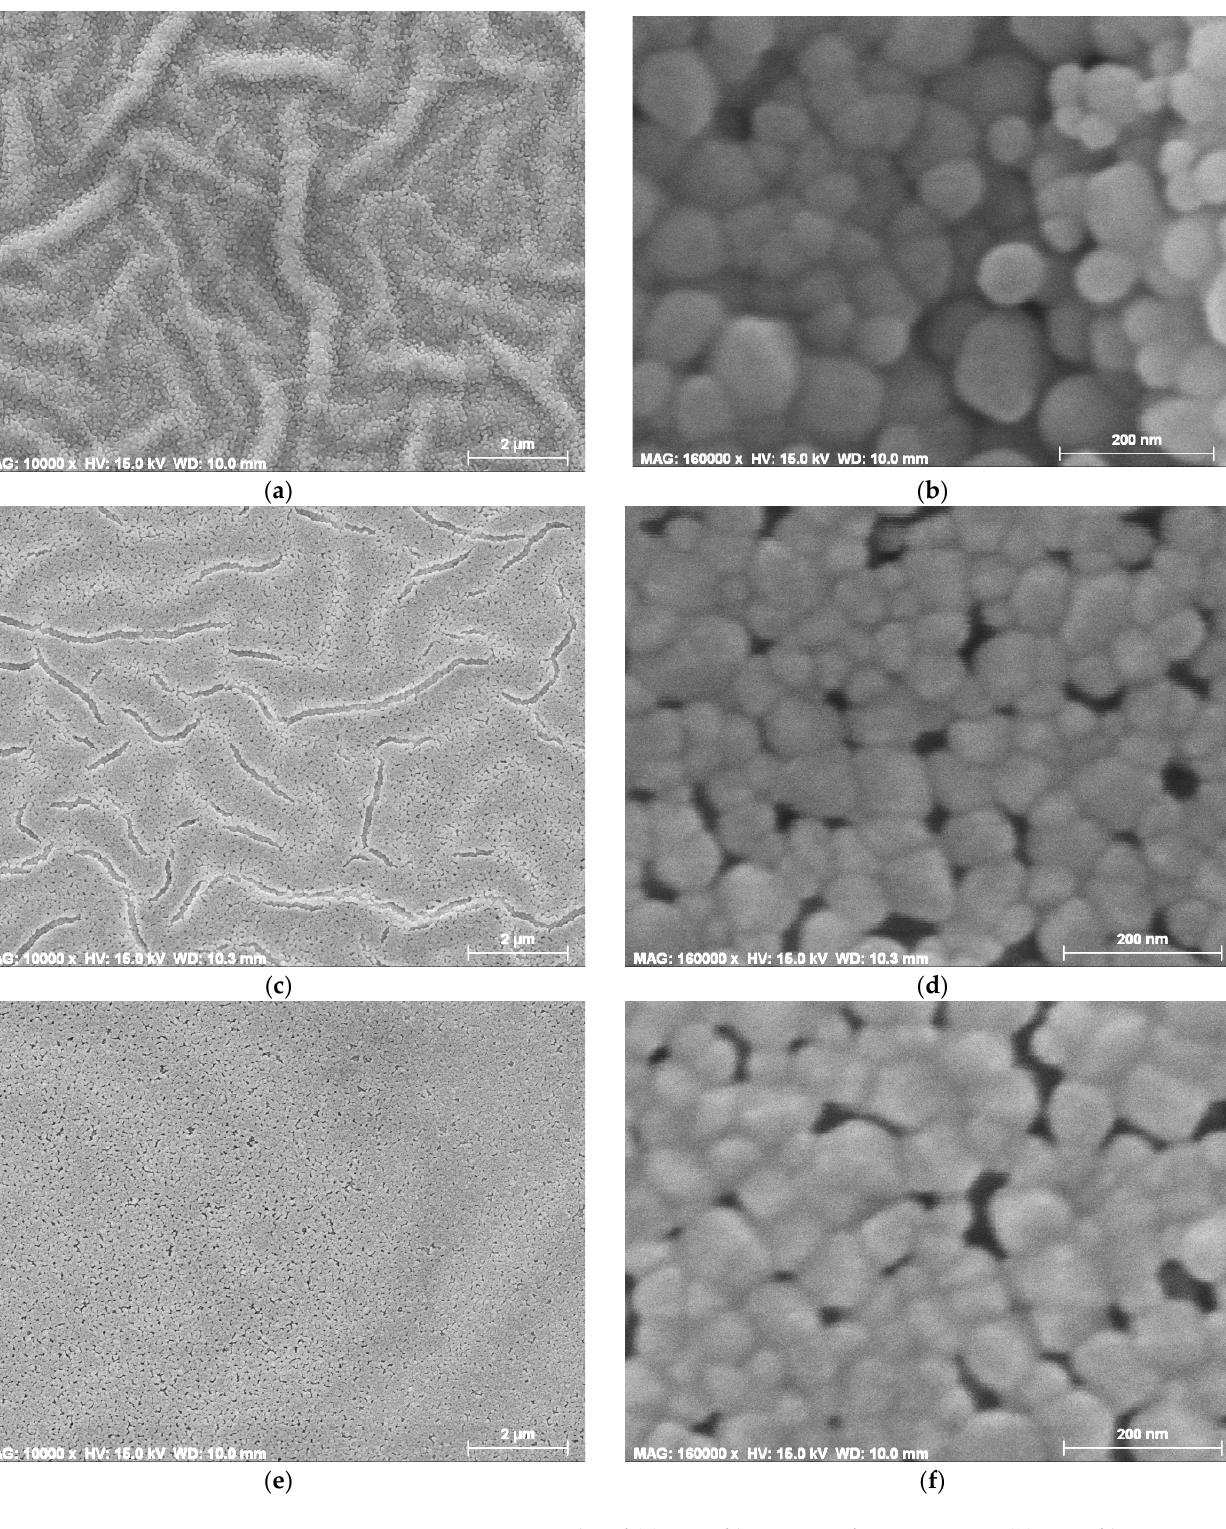
Figure 16. FESEM micrographs of ( a ) ZnO films, magnification 10,000; ( b ) ZnO films, magnification 160,000; ( c ) ZnO:Mg 0.5, magnification 10,000; ( d ) ZnO:Mg 0.5 films, magnification 160,000; ( e ) ZnO:Mg 3, magnification 10,000; ( f ) ZnO:Mg 3 films, magnification 160,000. The films were deposited on Si and annealed at 600 °C.